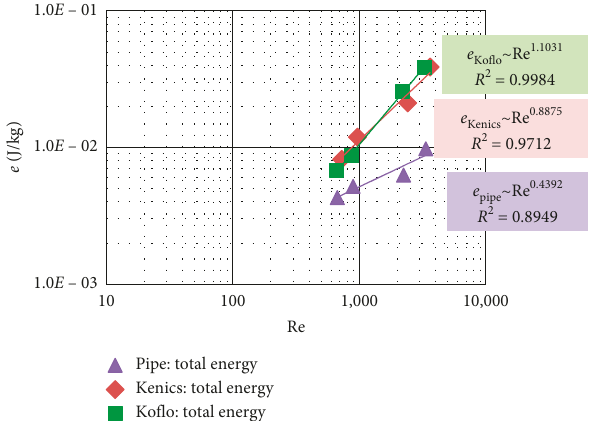
Figure 24: The comparison of total unit energy in the tested